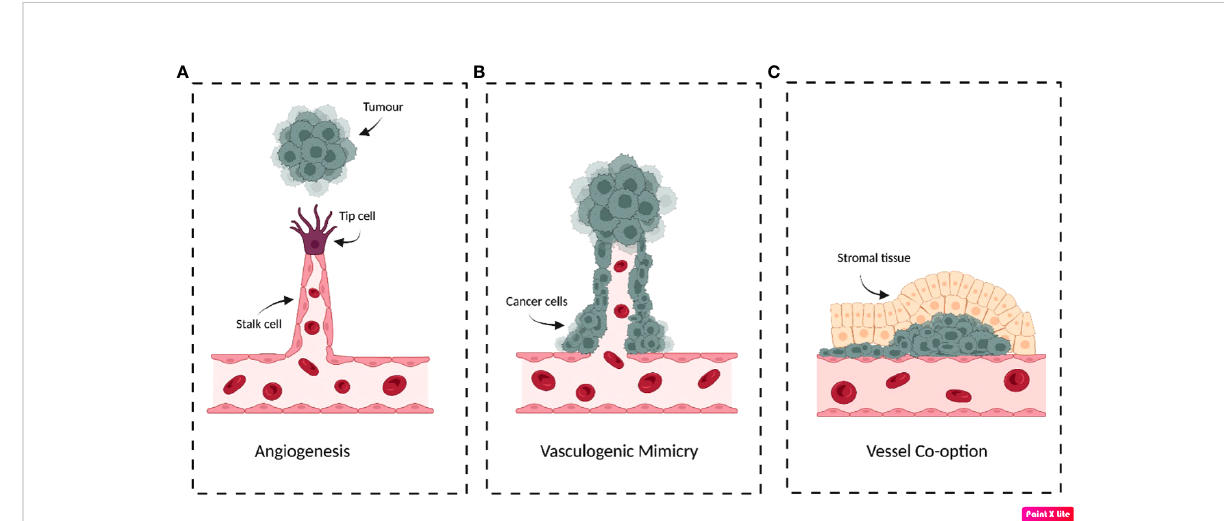
FIGURE 1 Schematic illustration demonstrating the possible mechanisms that tumours use to obtain blood supply. (A) Sprouting angiogenesis. In response to pro-angiogenic factors secreted by tumours, endothelial tip cells form that migrate towards the tumour ’ s growth factor signalling. (B) Vasculogenic/ vascular mimicry. Often in response to hypoxia, cancer cells differentiate into endothelial-like phenotypes to form tubular structures that resemble blood vessels to support the tumour. (C) Vessel co-option. Cancer cells migrate along the pre-existing vessel that supplies the tissue parenchyma. Cancer cells can form circular cuffs that surround the vessel and/or invade the surrounding stroma to expropriate the tissue blood supply. Original fi gure created with